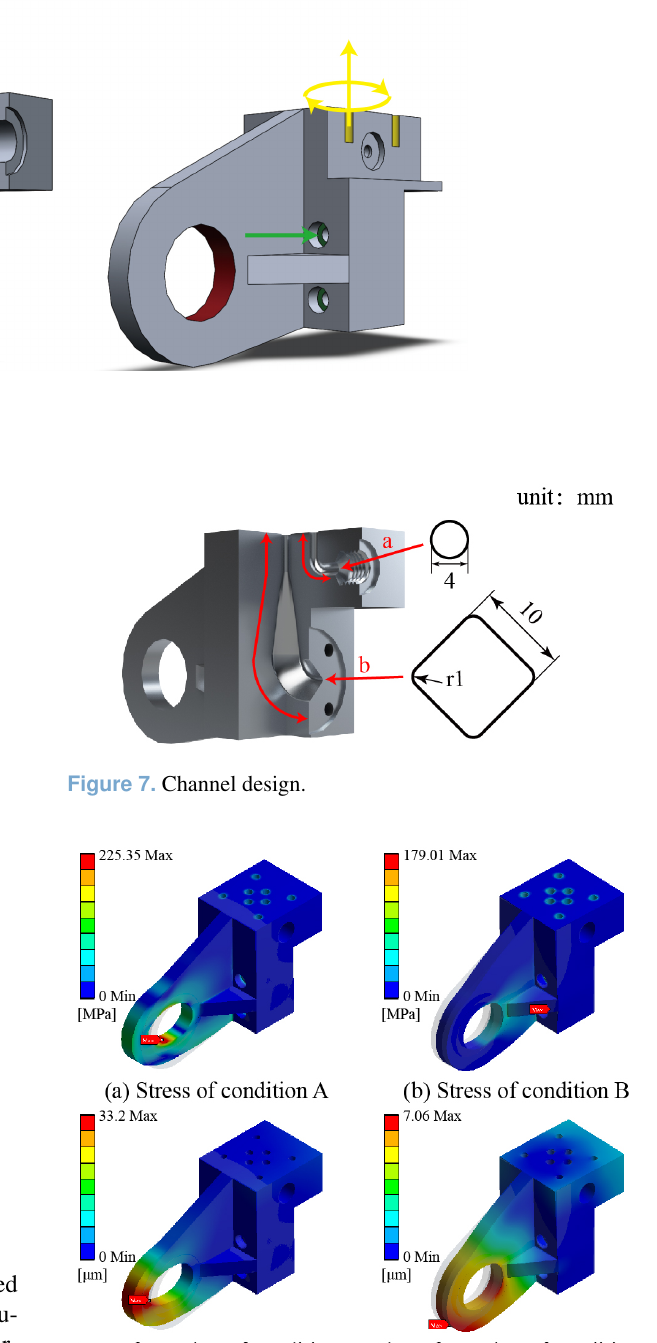
Figure 8. Stress and deformation of the conventional